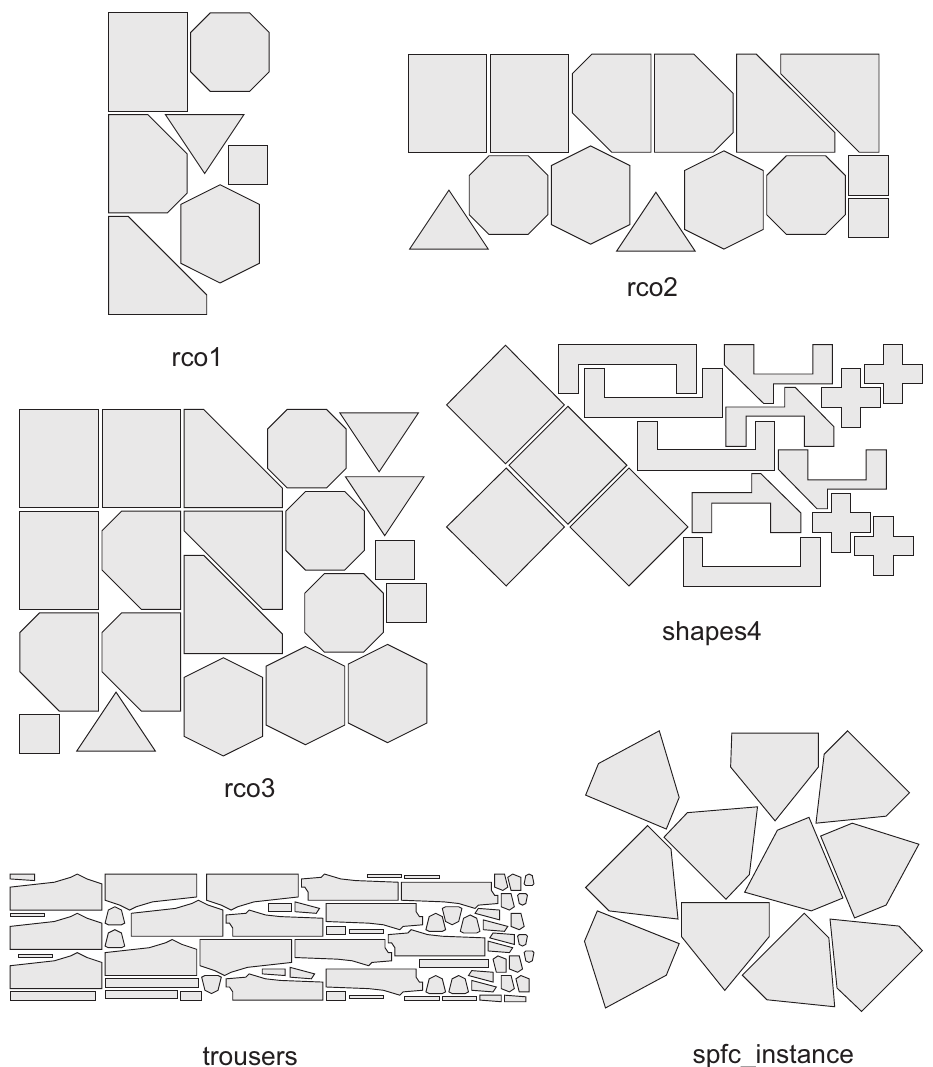
Figure A5. Third batch of instances with separated